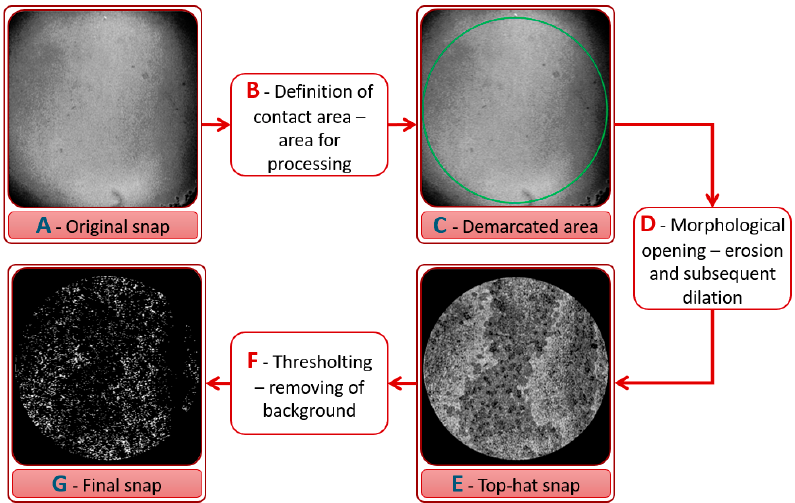
Figure 7. Snap processing diagram. ( A ) Original Snap ( B ) Definition of contact area-area for processing ( C ) Demarcated area ( D ) Morphological opening-erosion and subsequent dilation ( E ) Top-hat snap ( F ) Thresholting-removing of background ( G ) Final snap.